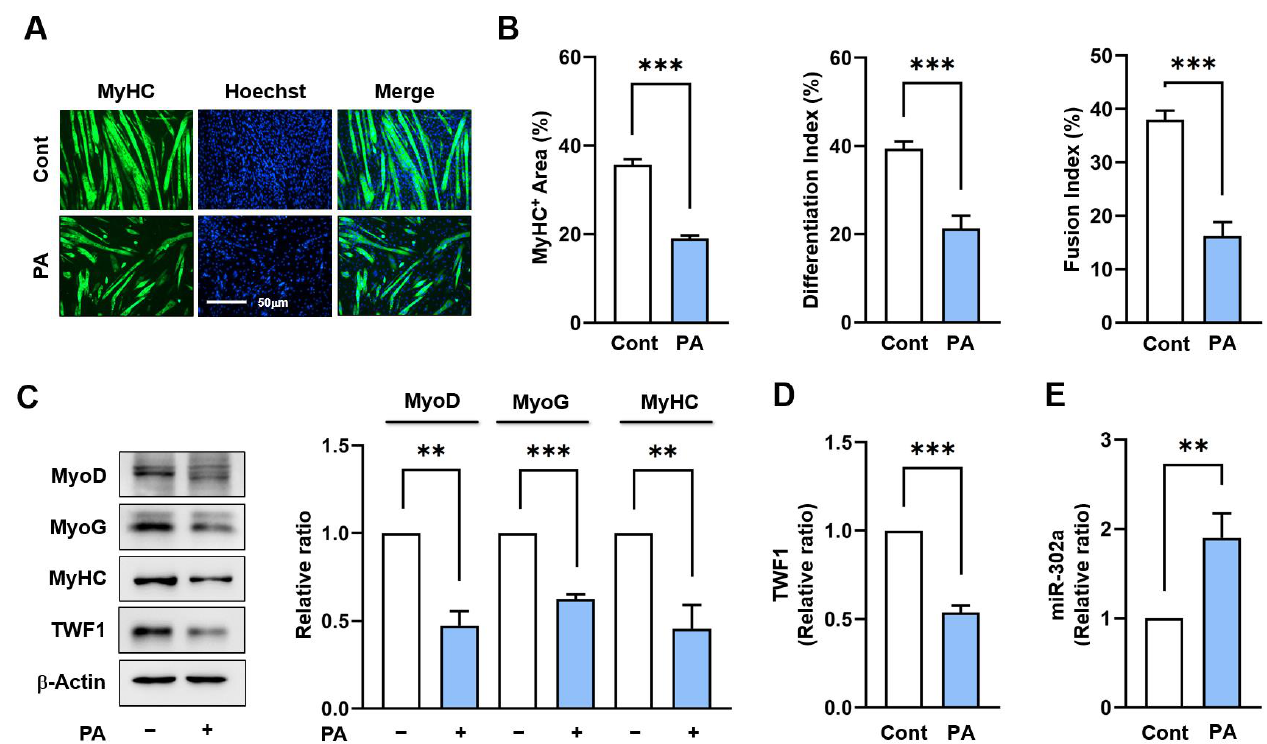
Figure 1. PA impairs myogenic differentiation and modulates TWF1 and miR-302a expression. C2C12 myoblasts were treated with PA (100 µ M) or a vehicle for 24 h and differentiated for 5 days. ( A ) Immunofluorescence staining for MyHC (MF20, green) and nucleus (Hoechst 34452, blue) on differentiation day 5. Scale bar: 50 μm. ( B ) Myogenic differentiation was analyzed using MyHC-positivity areas, differentiation and fusion indices as described in the Materials and Methods. ( C , D ) The expression levels of myogenic factors (MyoD, MyoG, and MyHC) and TWF1 were determined by immunoblots on differentiation day 3 and normalized versus β -actin by densitometry. ( E ) The expression levels of miR-302a were analyzed by RT- q PCR after 24 h of PA treatment and normalized versus U6. Results are expressed as relative ratios versus vehicle controls and presented as means ± standard errors ( n > 3); **, p < 0.01; ***, p < 0.001 vs. controls.